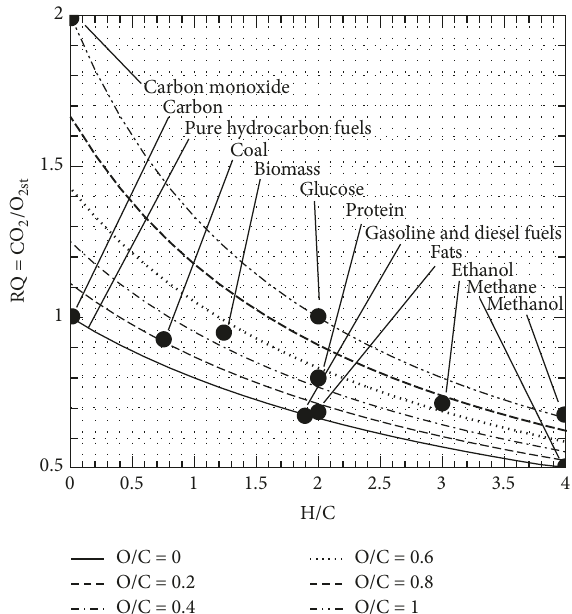
Figure 4: Variation of RQ with H/C ratio and O/C ratio of the C-H-O fuel. Gaseous and liquid fuels have lower RQ factor when compared to that of solid fossil and renewable fuels. CO 2 in tons per